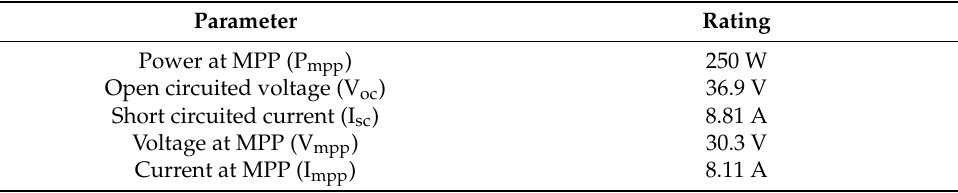
Table 1. Solar PV module ratings under STC.